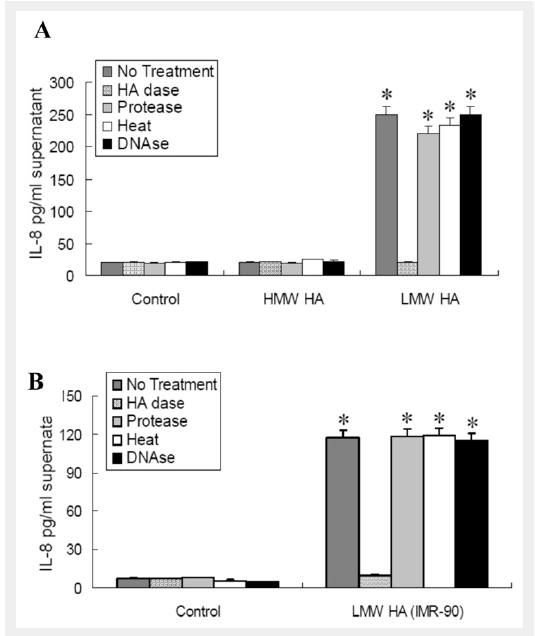
IL-8 production was stimulated by LMW-HA but not by HMW- HA in human transformed bronchial epithelial cells (BEAS-2B cells) BEAS-2B cells were incubated with LMW-HA, HMW HA, or no HA in serum-free media for 6 hours. A. Effect of LMW-HA from bovine vitreous humor and HMW HA from rooster comb on IL-8 production (n = 5); B. Effect of LMW-HA isolated from IMR-90 fibroblasts (n = 3) on IL-8 production. HAdase treatment completely blocked LMW-HA- induced IL-8 production. Protease treatment, heat treatment and DNAse pre-treatment had no effect on LMW-HA-induced IL-8 production. * p <0.05 vs HMW HA exposure and no HA control.